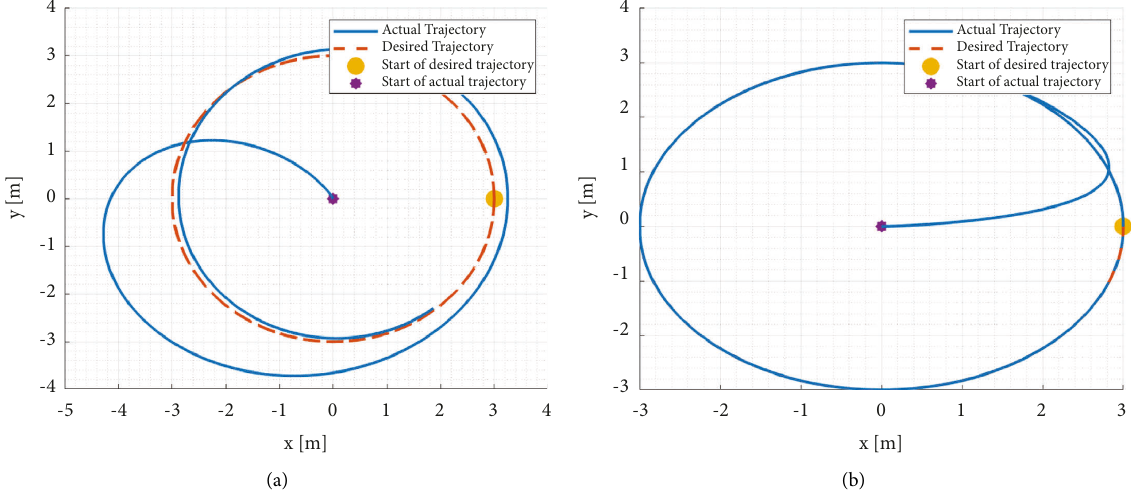
Figure 21: The trajectory for PD (a) and FBL with PD control (b) after 30 seconds.